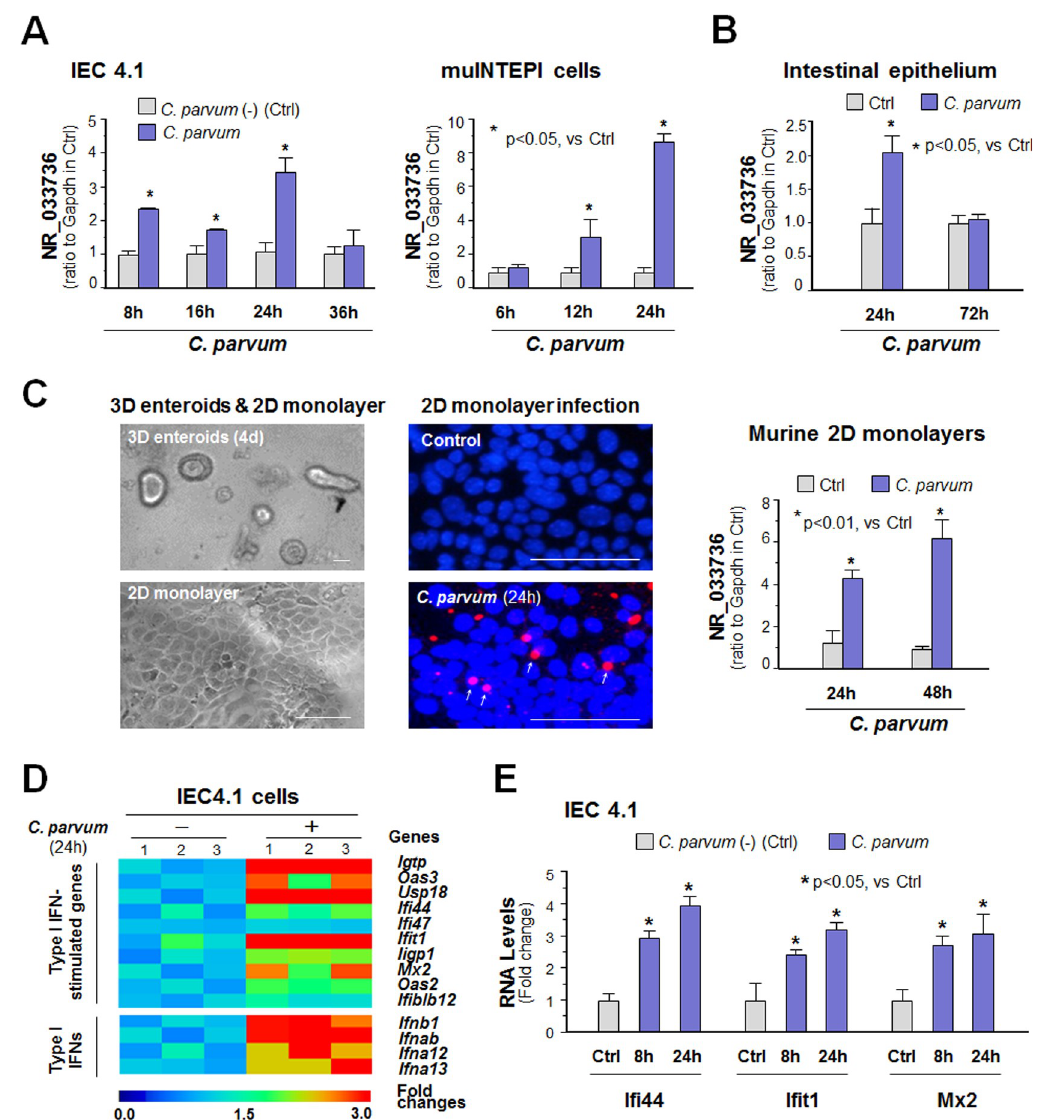
Fig 1. Upregulation of NR_033736 and activation of type I IFN signaling in intestinal epithelium following Cryptosporidium infection. (A) Upregulation of NR_033736 in cultured murine intestinal epithelial cells (IEC4.1 and muINTEPI cells) following C . parvum infection. IEC4.1 and muINTEPI cells were exposed to C . parvum infection for 6–36 h and expression level of NR_033736 was validated by using qRT-PCR. (B) Upregulation of NR_033736 in murine intestinal epithelium following C . parvum infection in vivo . Neonates of mice at 5 days of age received C . parvum administration by oral and intestinal ileum epithelium were isolated after infection for 24–72 h. Expression level of NR_033736 was quantified by using qRT-PCR. (C) Upregulation of NR_033736 in 2D murine intestinal epithelial monolayers following C . parvum infection ex vivo . The crypt units of small intestinal epithelium from neonates of 5 days old were isolated and cultured into 2D monolayers followed by exposure to C . parvum infection for 24–48 h, as shown by phase and immunofluorescence microscopy. NR_033736 expression was validated by using qRT-PCR. (D) Upregulation of the selected type I IFN-controlled genes and type I IFN genes in IEC4.1 cells following C . parvum infection for 8 h. The expression levels of the genes were quantified and presented as a heatmap representing fold changes in infected cells compared with that in non-infected control. (E) Expression levels of selected type I IFN-controlled genes (i.e., Ifi44 , Ifit1 , and Mx2 ) in IEC4.1 cells following C . parvum infection for 8h and 24 h. Data represent three independent experiments. � P < .05 vs cells of non-infected control (Ctrl).